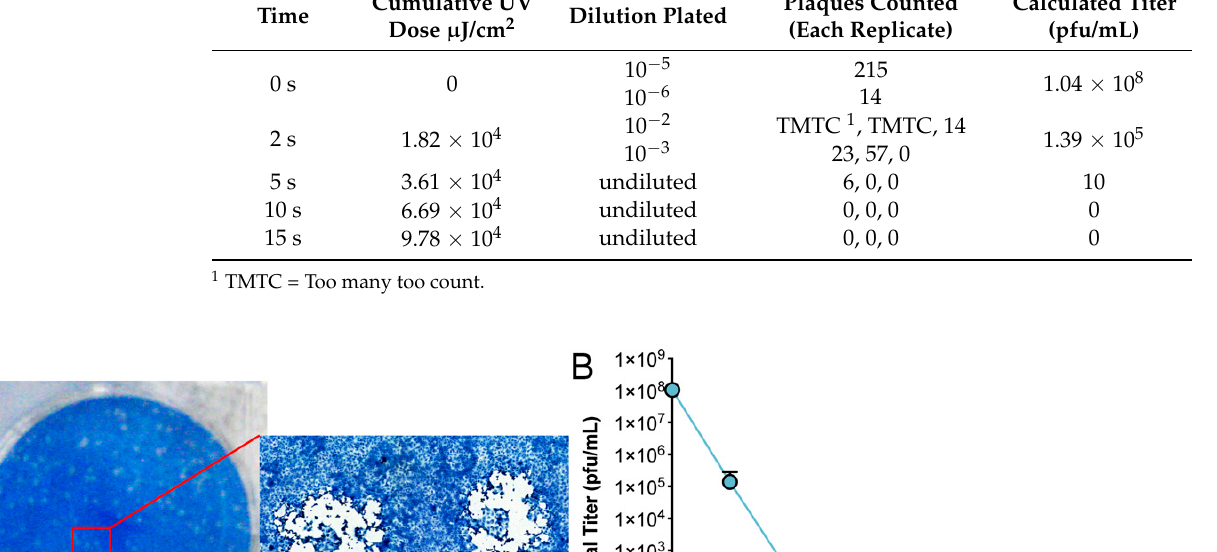
Table 2. UV-C inactivation of 15 mL in open-top bacterial Dish.